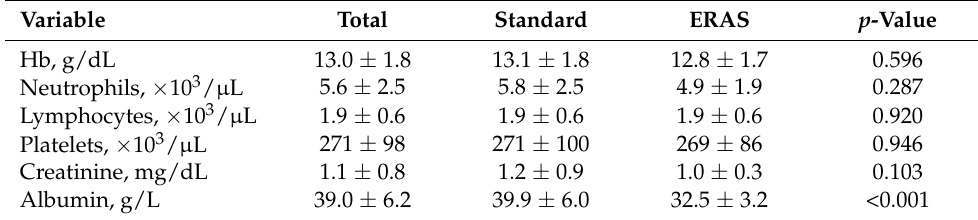
Table 3. The pre-operative blood